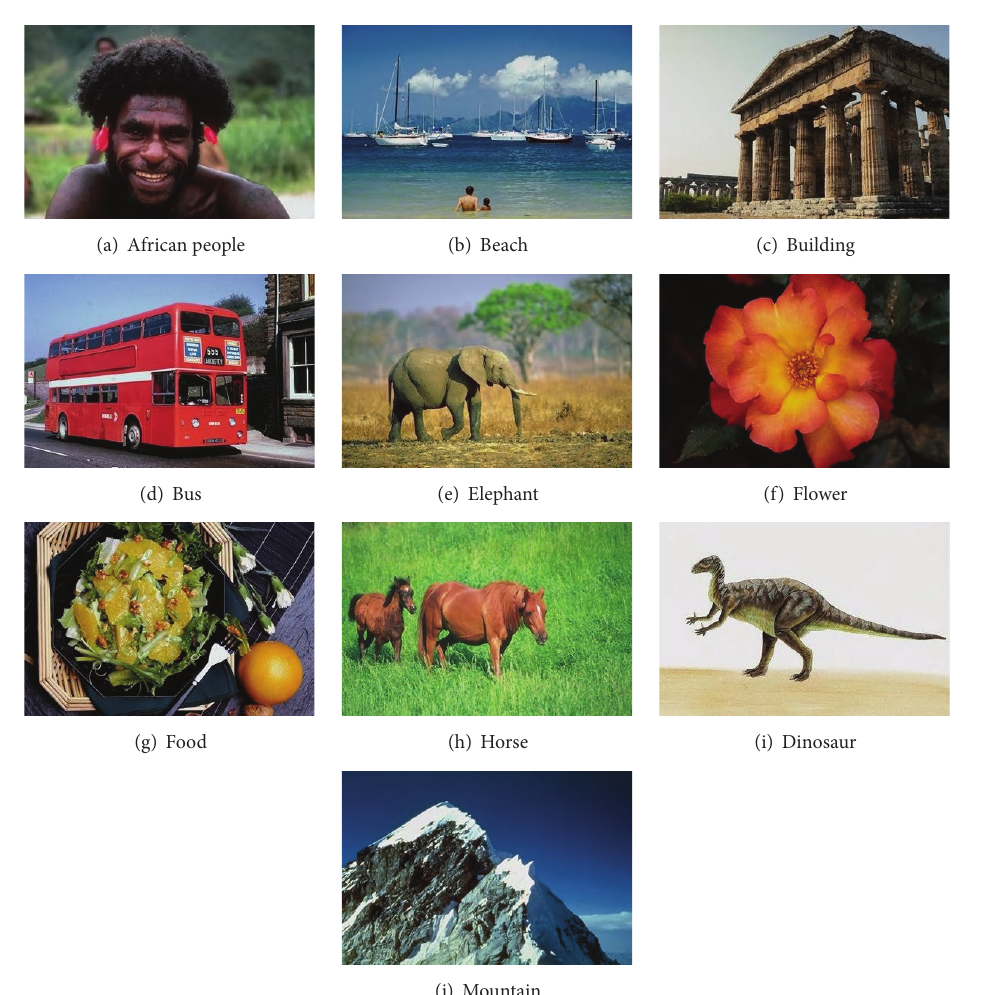
Figure 7: Example images of the SIMPLIcity